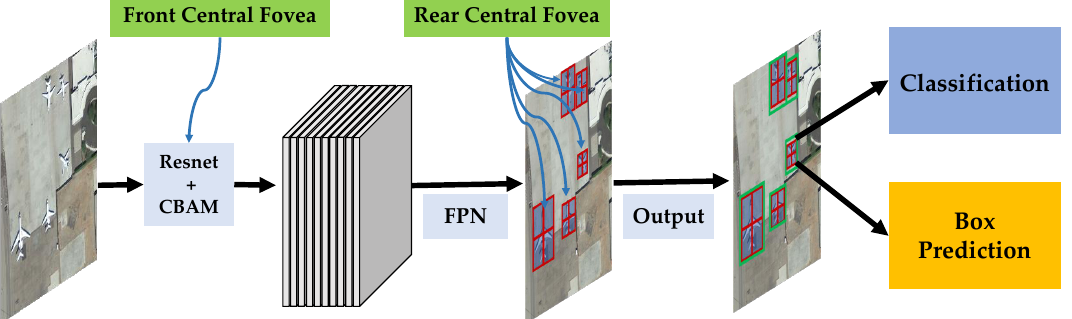
Figure 3. The architecture of the proposed methodology. The proposed framework mainly contains two attention modules: front central fovea (FCF) and rear central fovea (RCF). The FCF and RCF are complementary for object